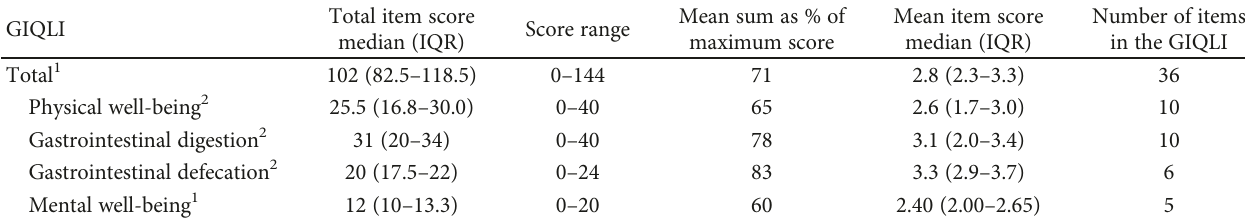
Table 4: Results of the QoL assessment by GIQLI in 13 patients with